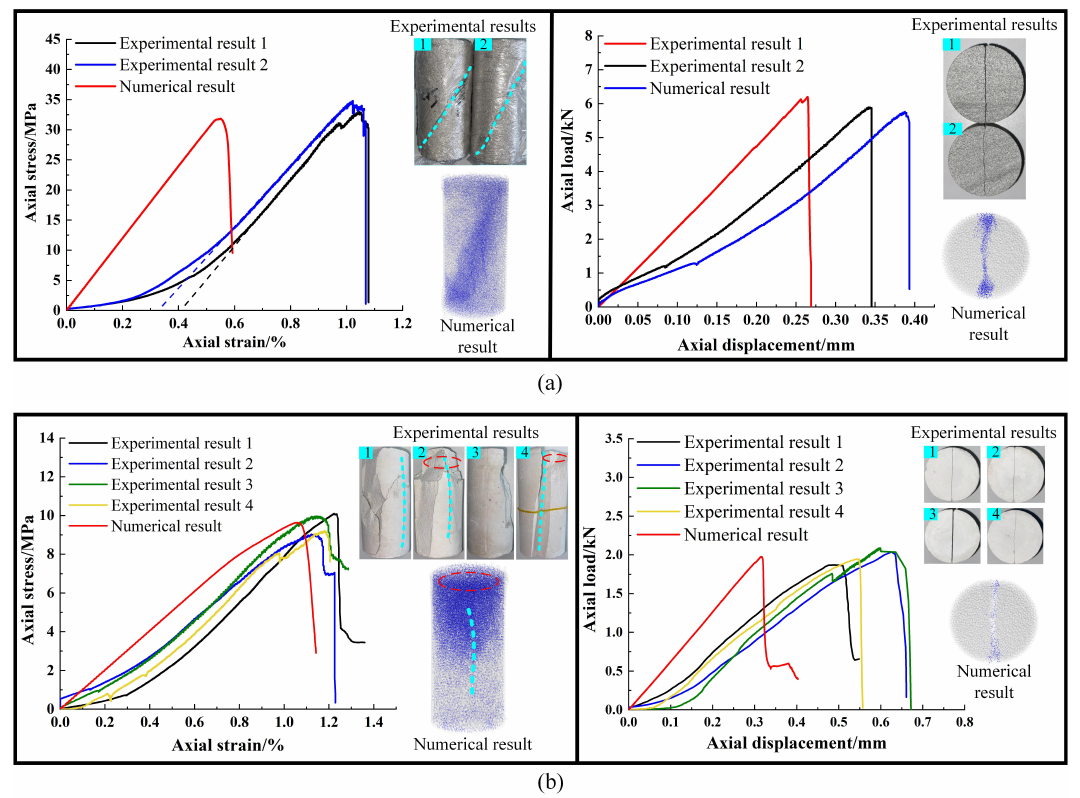
Figure 8. Strength curve and failure pattern of experimental and numerical results: ( a ) white sandstone; ( b ) cement. Table 3. Microscopic parameter values used in simulation.